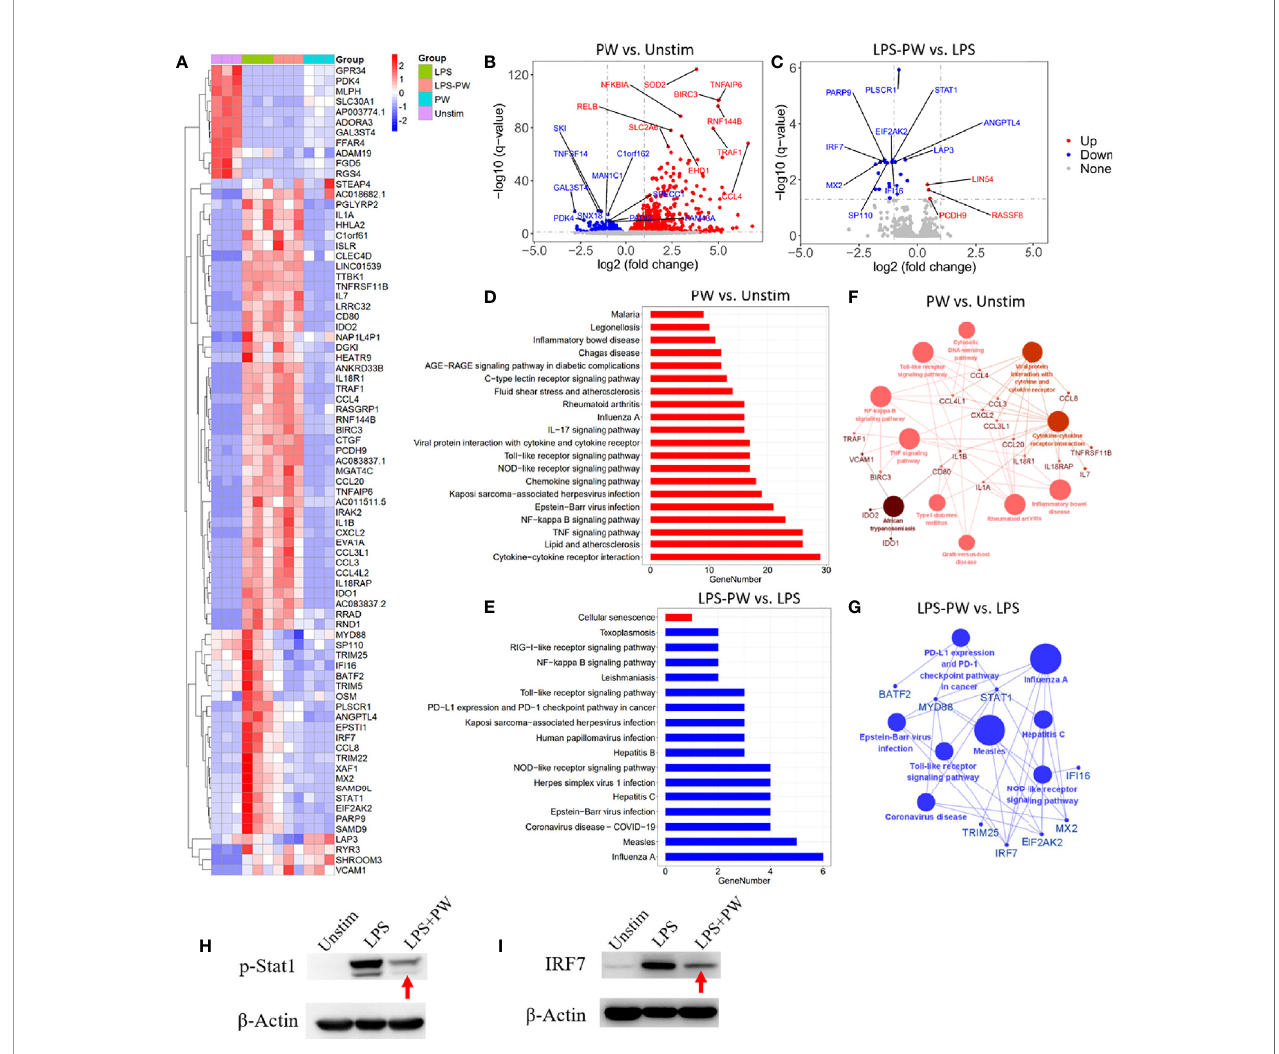
FIGURE 4 | Transcriptome analysis by RNA-Seq de fi ning the immunomodulatory activities of PW in THP-1-derived macrophages. (A) The heatmap of the top 79 differentially expressed genes (DEGs) among the four experimental groups: LPS stimulation (LPS), LPS with PW treatment (LPS-PW), PW treatment only (PW) and unstimulated control (Unstim); each with three biological replicates; top 57 DEGs of adjusted p-value < 0.05 and |log2 (fold change)| > 2 were identi fi ed for PW vs. Unstim group, and 22 DEGs with adjusted p-value < 0.05 and |log2 (fold change)| > 0.5 were shown for LPS-PW vs. LPS group. (B, C) Volcano plots showing all the gene expression pattern and highlighting the top 10 up- or down-regulated DEGs in PW vs. Unstim group (B) and LPS-PW vs. LPS group (C) ; the red, blue and gray color represents up-regulated, down-regulated and non-signi fi cant genes, respectively; the threshold line setting for adjusted p-value = 0.05 and |log2 (fold change)| = 1. (D, E) KEGG pathway enrichment analysis for PW vs. Unstim (D) and LPS-PW vs. LPS (E) ; all the pathways were signi fi cantly enriched with an adjusted p-value < 0.05; the red and blue color represents up-regulated and down-regulated pathways, respectively. (F G) Interaction analysis of pathways and related genes by ClueGO for PW vs. Unstim group (F) and LPS-PW vs. LPS group (G) ; the red and blue color represents up-regulated and down-regulated pathways and genes, respectively; the cut-off p-value = 0.05. (H, I) Immunoblotting con fi rming the inhibition of STAT1 activation (phosphorylation of STAT1, p-STAT1) at 2h (H) and IRF7 expression at 24 h (I) by PW under LPS stimulation; b -actin as the internal control. PW = 100 nM, LPS = 10 ng/mL, N ≥